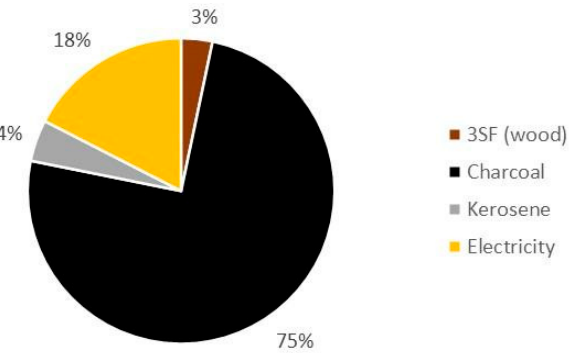
Figure 9. Mix of fuels used for all stove events (smart meter and Stovetrace datasets: Phase 2 and Phase 3).